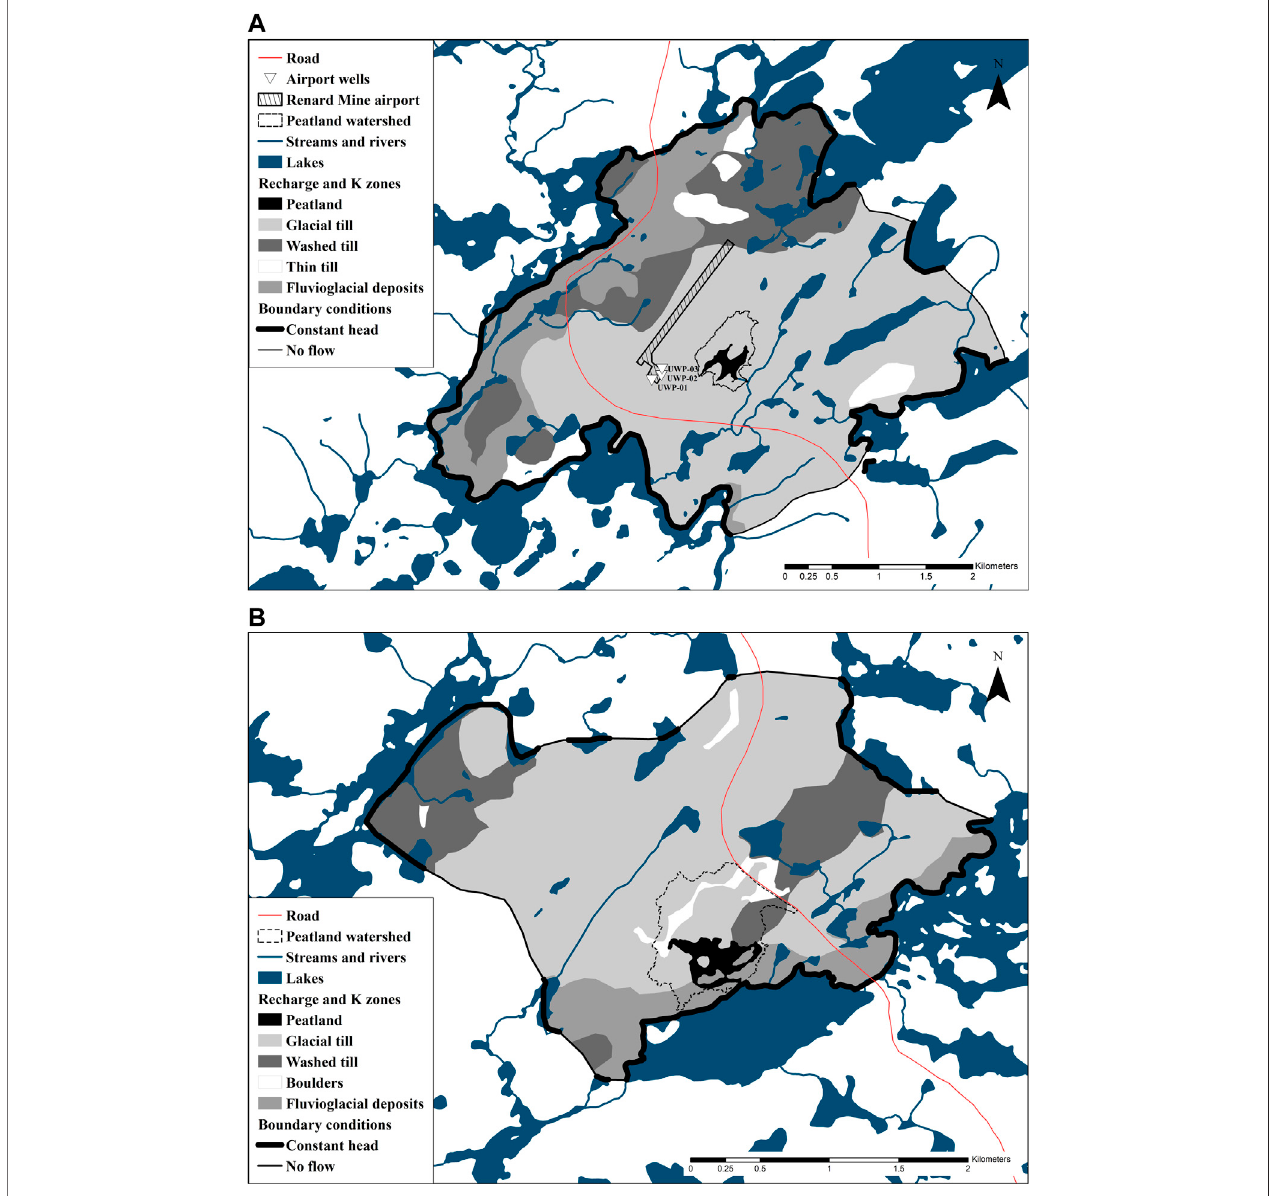
FIGURE 2 | Conceptual groundwater fl ow context, showing boundary conditions as well as recharge zones and hydraulic conductivity zones for (A) the Misask peatland and (B) the Cheinu peatland.